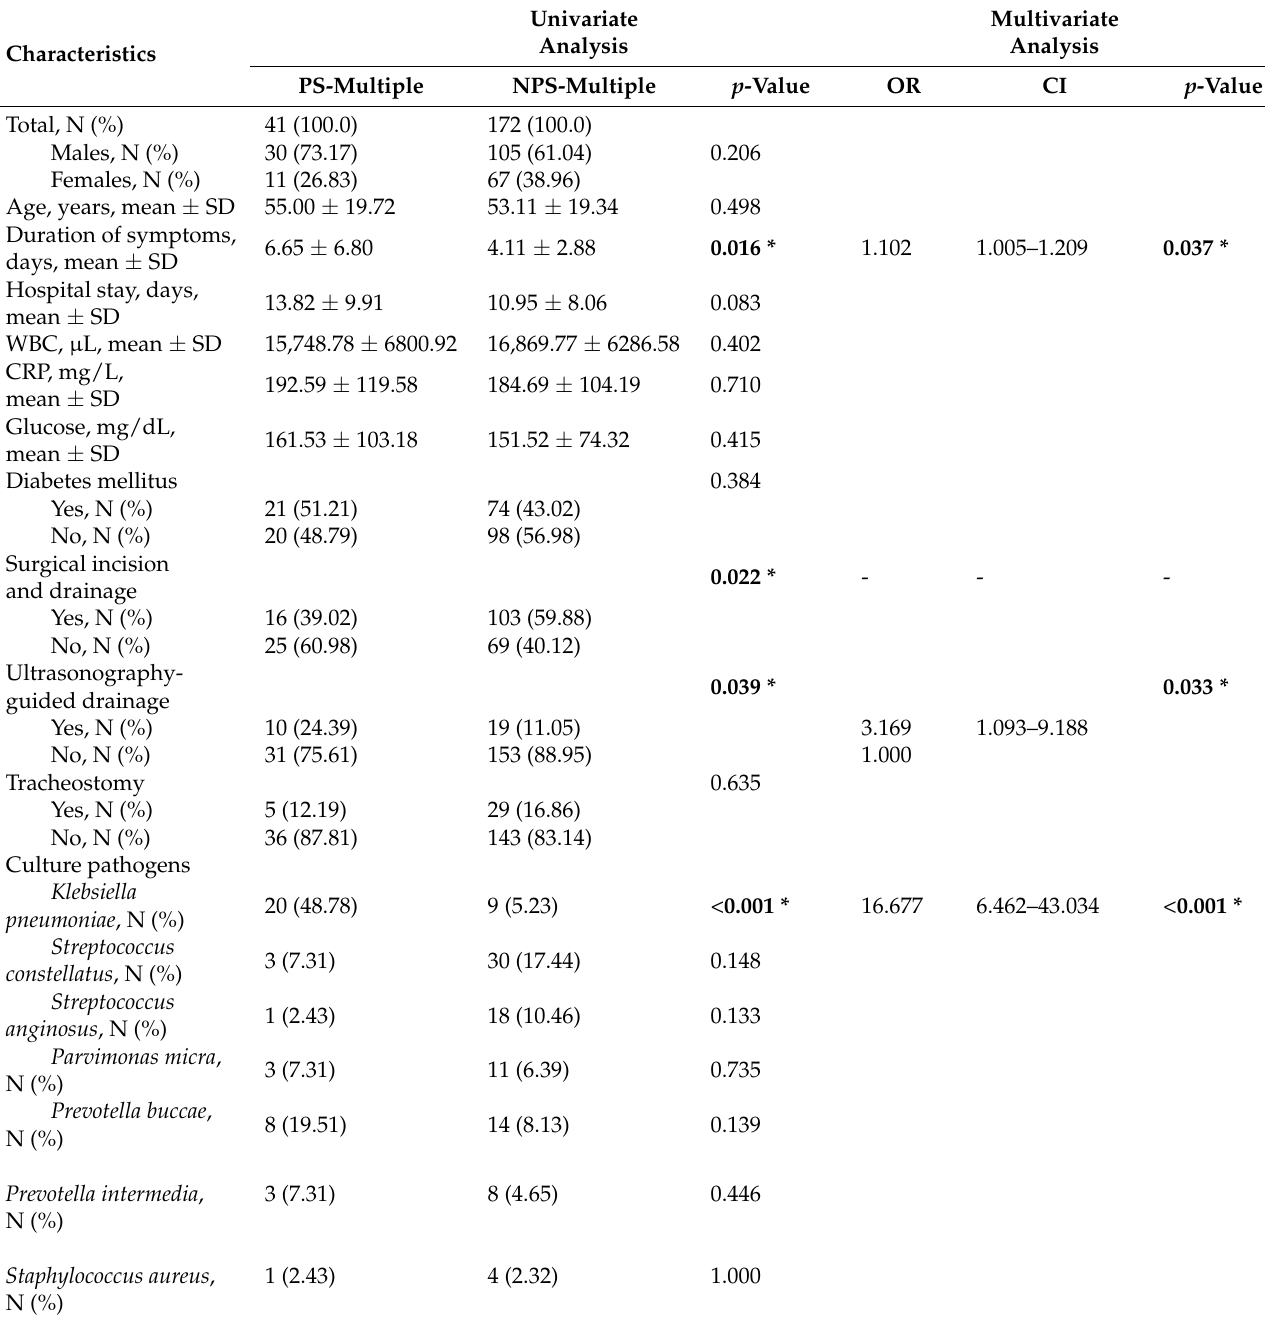
Table 4. Clinical data from the PS-multiple and NPS-multiple deep neck infection